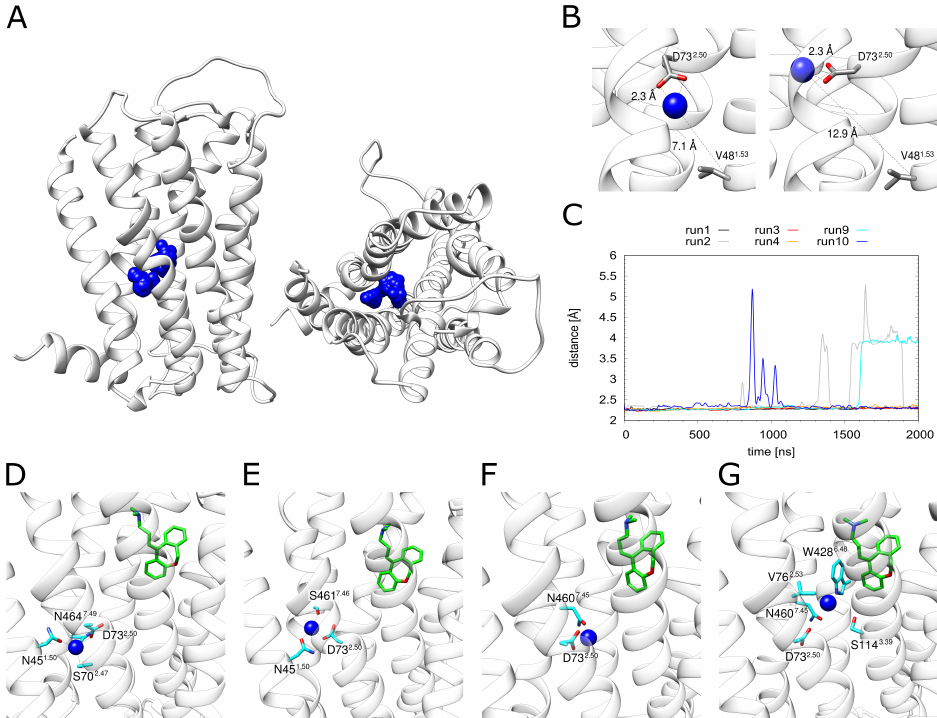
Figure 4. Dynamics of the sodium ion. ( A ) H 1 R structure (white ribbons) depicting the Na+ position (blue spheres) derived from simulation at time intervals of 1 ns. ( B ) The Na+ ion can adopt different positions in the binding pocket while still remaining attached to D73 2.50 . ( C ) Distance between D73 2.50 and the sodium ion for all simulations that contained a sodium ion. H 1 R-DS (run1, run2), H 1 R-DSP (run3, run4) and H 1 R-S (run9, run10). ( D – G ) Frames from the H 1 R-DS (run2) simulation at 0 ns, 100 ns, 1000 ns and 1700 ns. Sodium is depicted as a blue sphere, interacting residues are shown in cyan and the ligand doxepin is highlighted by green highlighted carbon atoms. The receptor is shown as a white